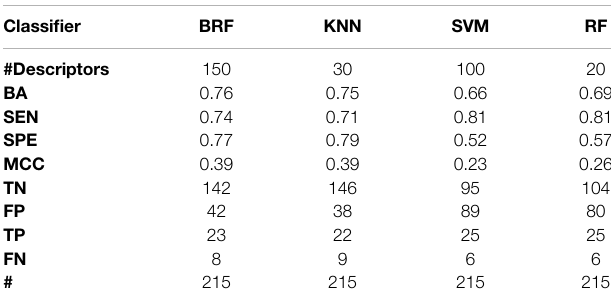
TABLE 2 | Performance of the best models developed on the HSE/LSE + NSE + INA partitioning scheme on the TeS. For each model, the following statistics are reported: Balanced Accuracy (BA), Sensitivity (SEN), Speci fi city (SPE), Matthews Correlation Coef fi cient (MCC), number of True Negatives (TN), False